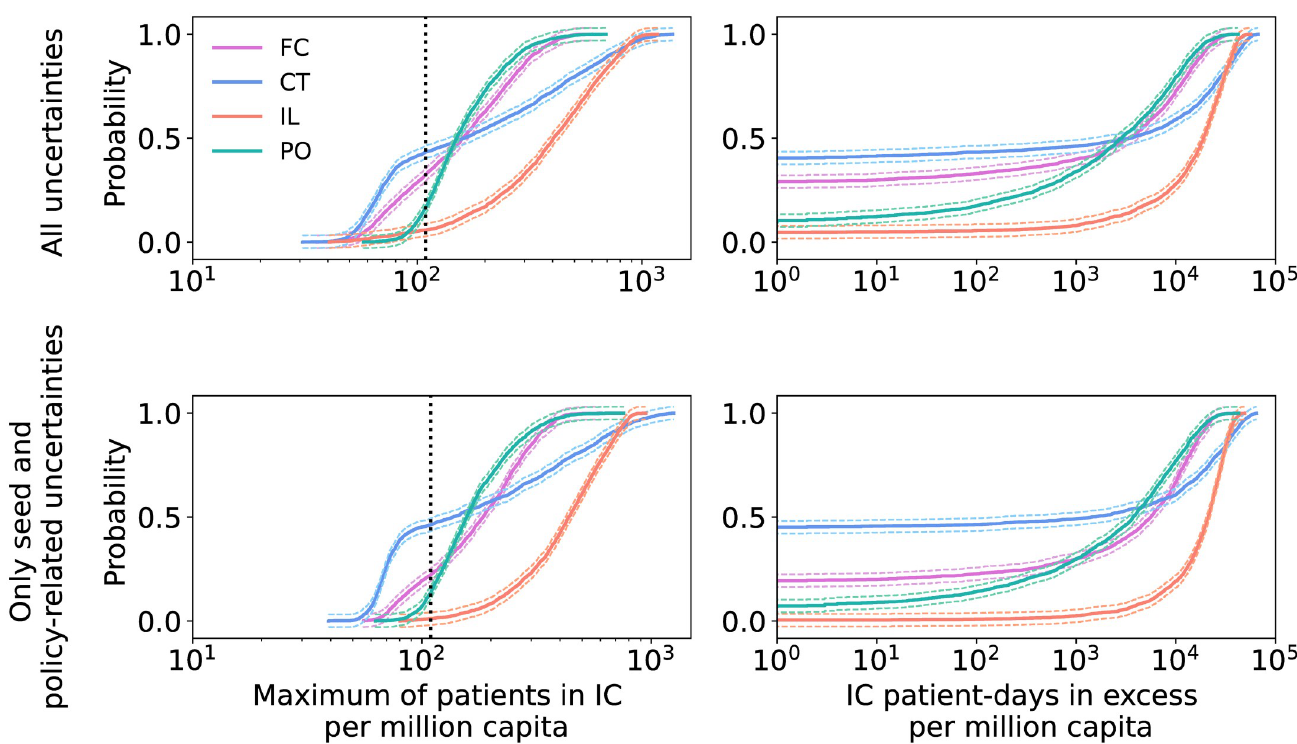
Fig 2. Empirical cdfs for Flattening the Curve, Contact Tracing, Intermittent Lockdown and Phased Opening. Top row: results with policy-related and non- policy-related uncertainties. Bottom row: outcomes with uncertainties only in the policy-related parameters and in the random seed. The vertical dotted black line indicates the maximum IC capacity, while the thinner colored lines denote the 95%-CI given by the Dvoretzky-Kiefer-Wolfowitz inequality. Note that the cdfs for the second QoI (right column) do not start from zero probability because the distributions have a non-zero probability that the number of IC patient-days in excess is